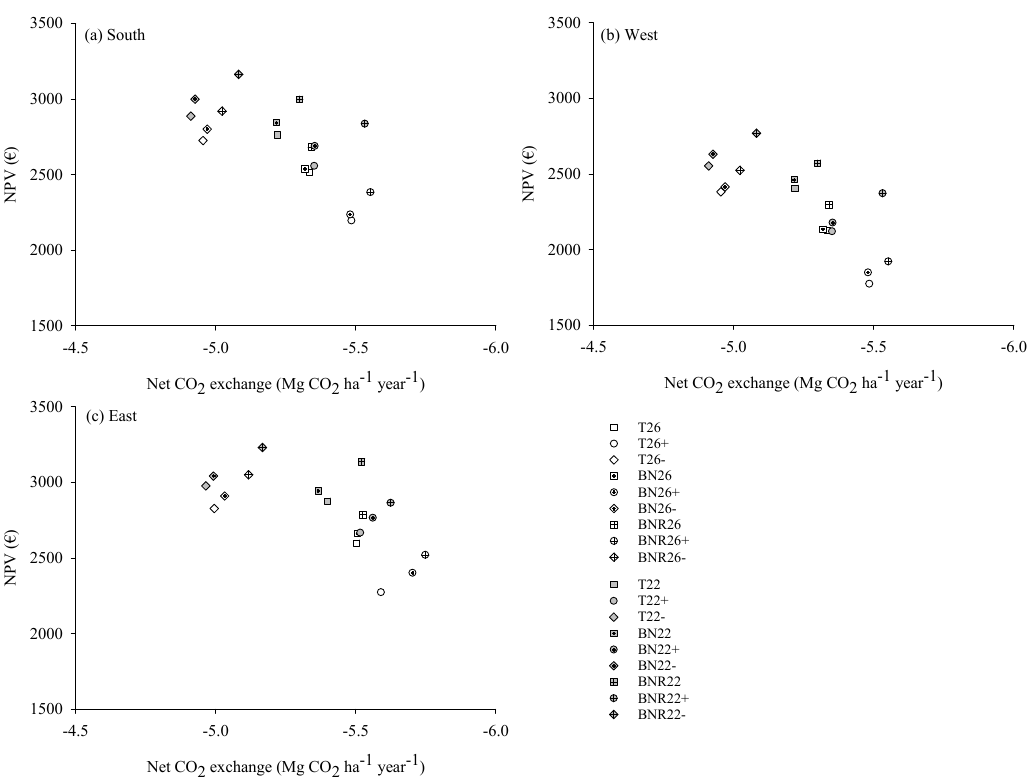
Figure 3. Net present value (NPV, € ha − 1 ) and annual net CO 2 exchange (Mg CO 2 ha − 1 year − 1 ) over the 40-year period for different management scenarios and three different harvest intensities including timber (T), timber and logging residues, without (BN) and with coarse roots and stumps (BNR) in the final felling made at DBH of 26 cm and 22 cm in southern ( a ), western ( b ) and eastern ( c ) sub-regions of Finland. For the key of the management scenarios, see Table 1.